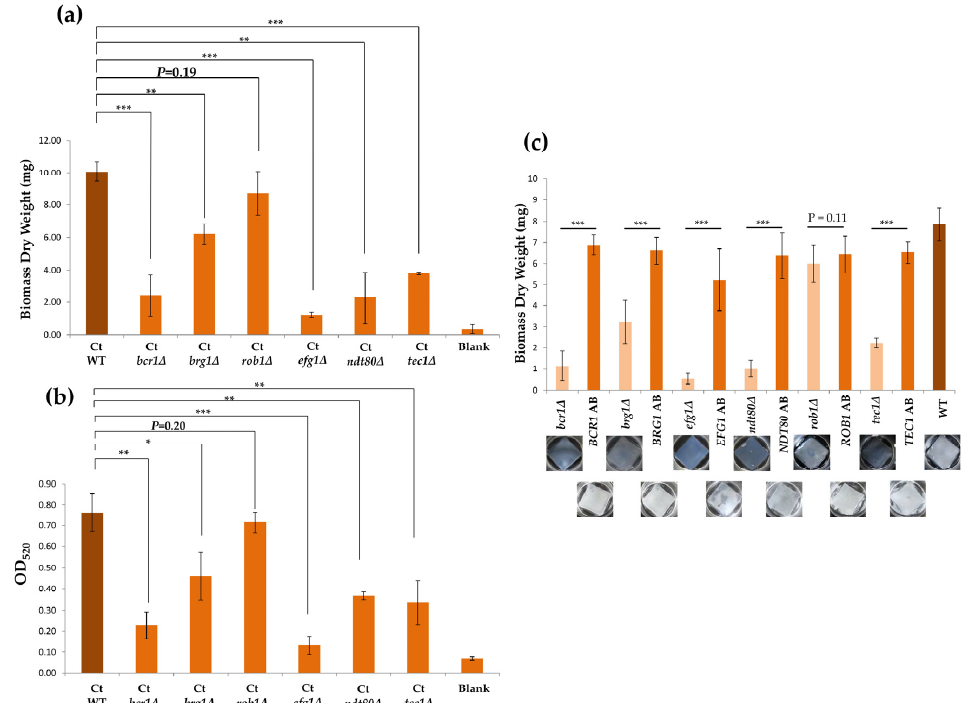
Figure 5. Except the rob1 Δ mutant strain, the lack of each gene in C. tropicalis caused a significant reduction in biofilms. Biofilms were determined by ( a ) biomass dry weight and ( b ) the OD 600 at the wavelength for crystal violet absorbance. Each experiment was repeated independently at least three times. ( c ) Reintroduction of each functional gene in each respective mutant strain except the ROB1 complementary strain was able to recover biofilm formation. Values are the mean ± SD from five replicates. * p < 0.05, ** p < 0.01, and *** p < 0.001.